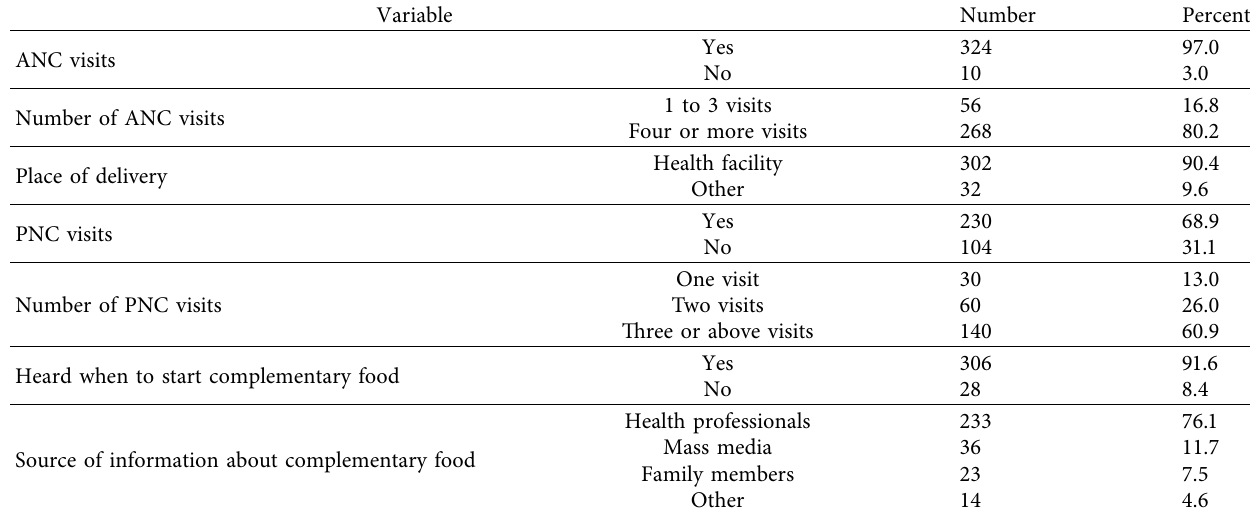
Table 3: Maternal health-service utilization and child-feeding